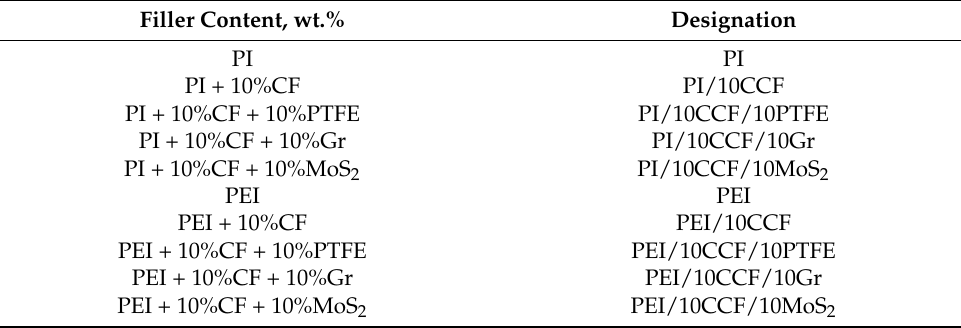
Table 8. Compositions and designations of the investigated polymer composites. Filler Content,